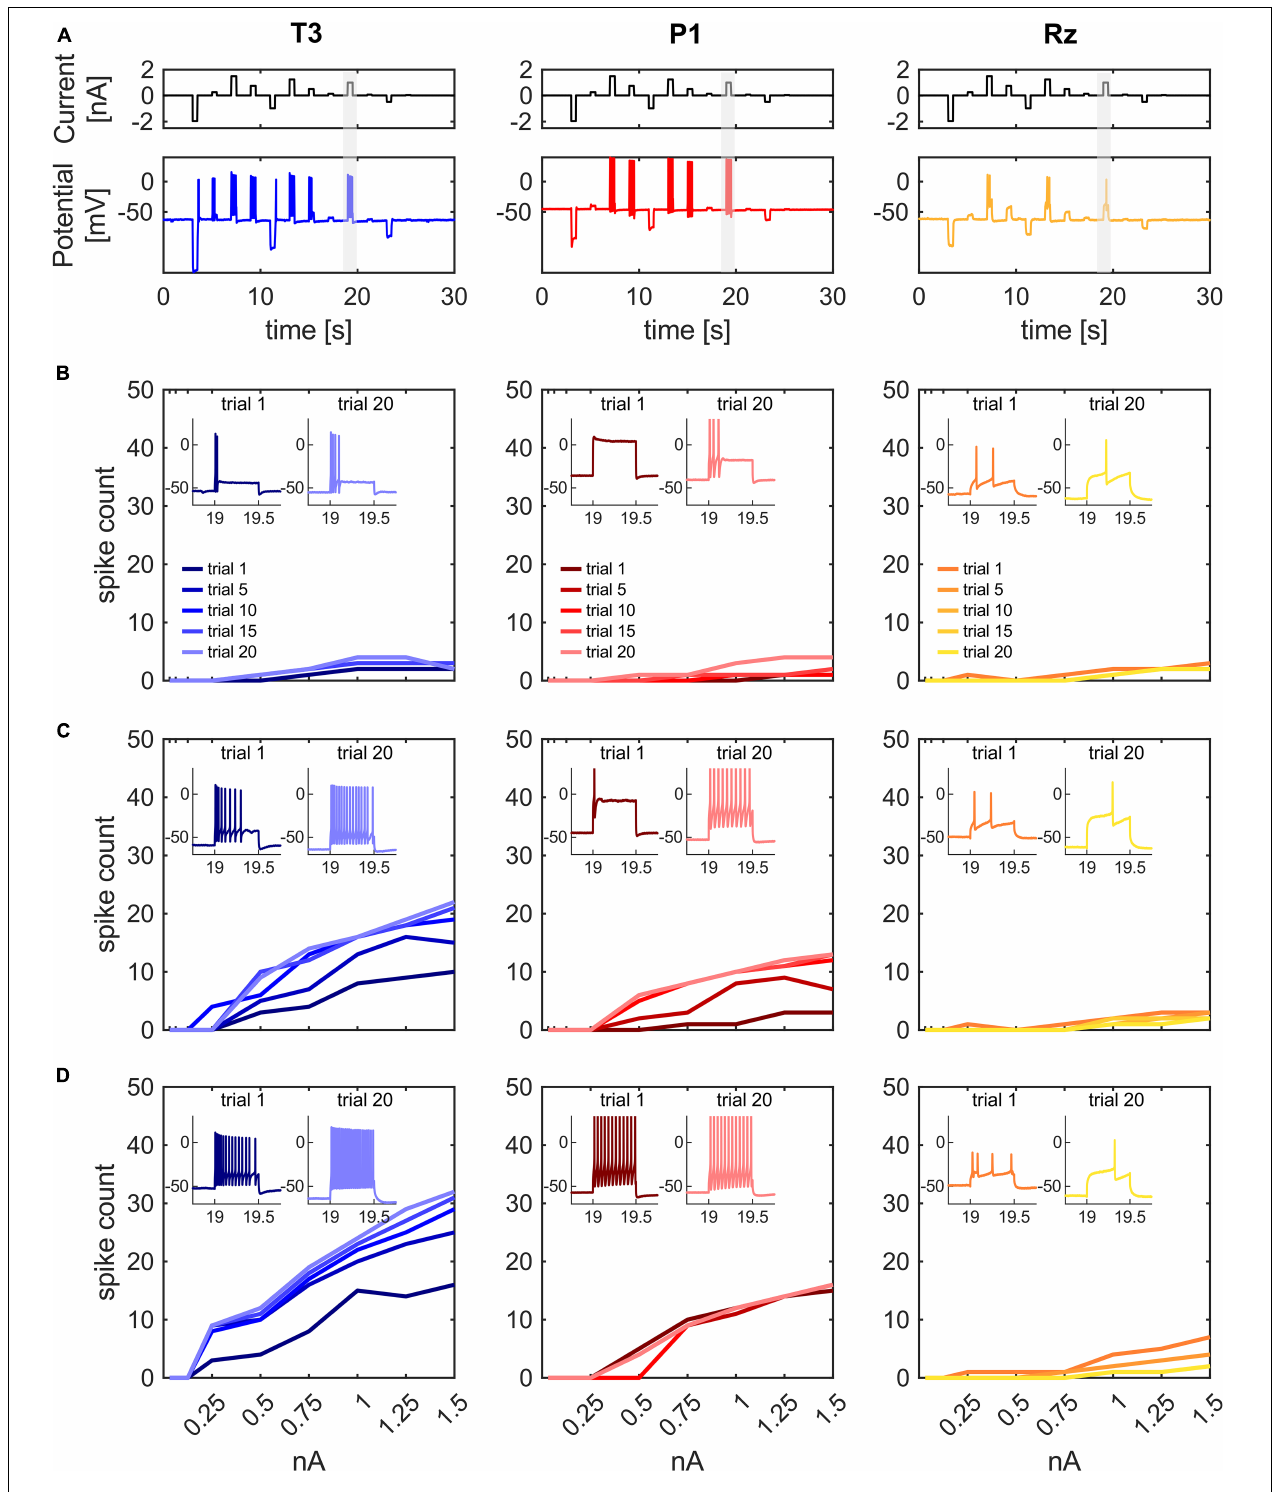
FIGURE 1 | Stimulus protocol with exemplary recordings and fI curves for T, P and Rz. (A) The stimulus protocol used in this study, consisting of pseudo-randomized step currents applied intracellularly. Example recordings of a typical T3 (blue), P1 (red) and Rz (yellow) cell at trial 10 (after 5 min). The gray bar highlights the 500 ms long 1 nA step current, which is taken as representative response in the following analyses. (B–D) fI-curves for three different exemplary cells of each cell type in trials 1, 5, 10, 15, and 20 (earlier trials are shown in darker colors). The y-axis shows the absolute numbers of spikes during the step currents of 500 ms each. Insets show the responses to the 1 nA current pulse in trials 1 (at the start of the recording) and 20 (after 10 min) with recording time in seconds on the x-axis and membrane potential in mV on the y-axis.